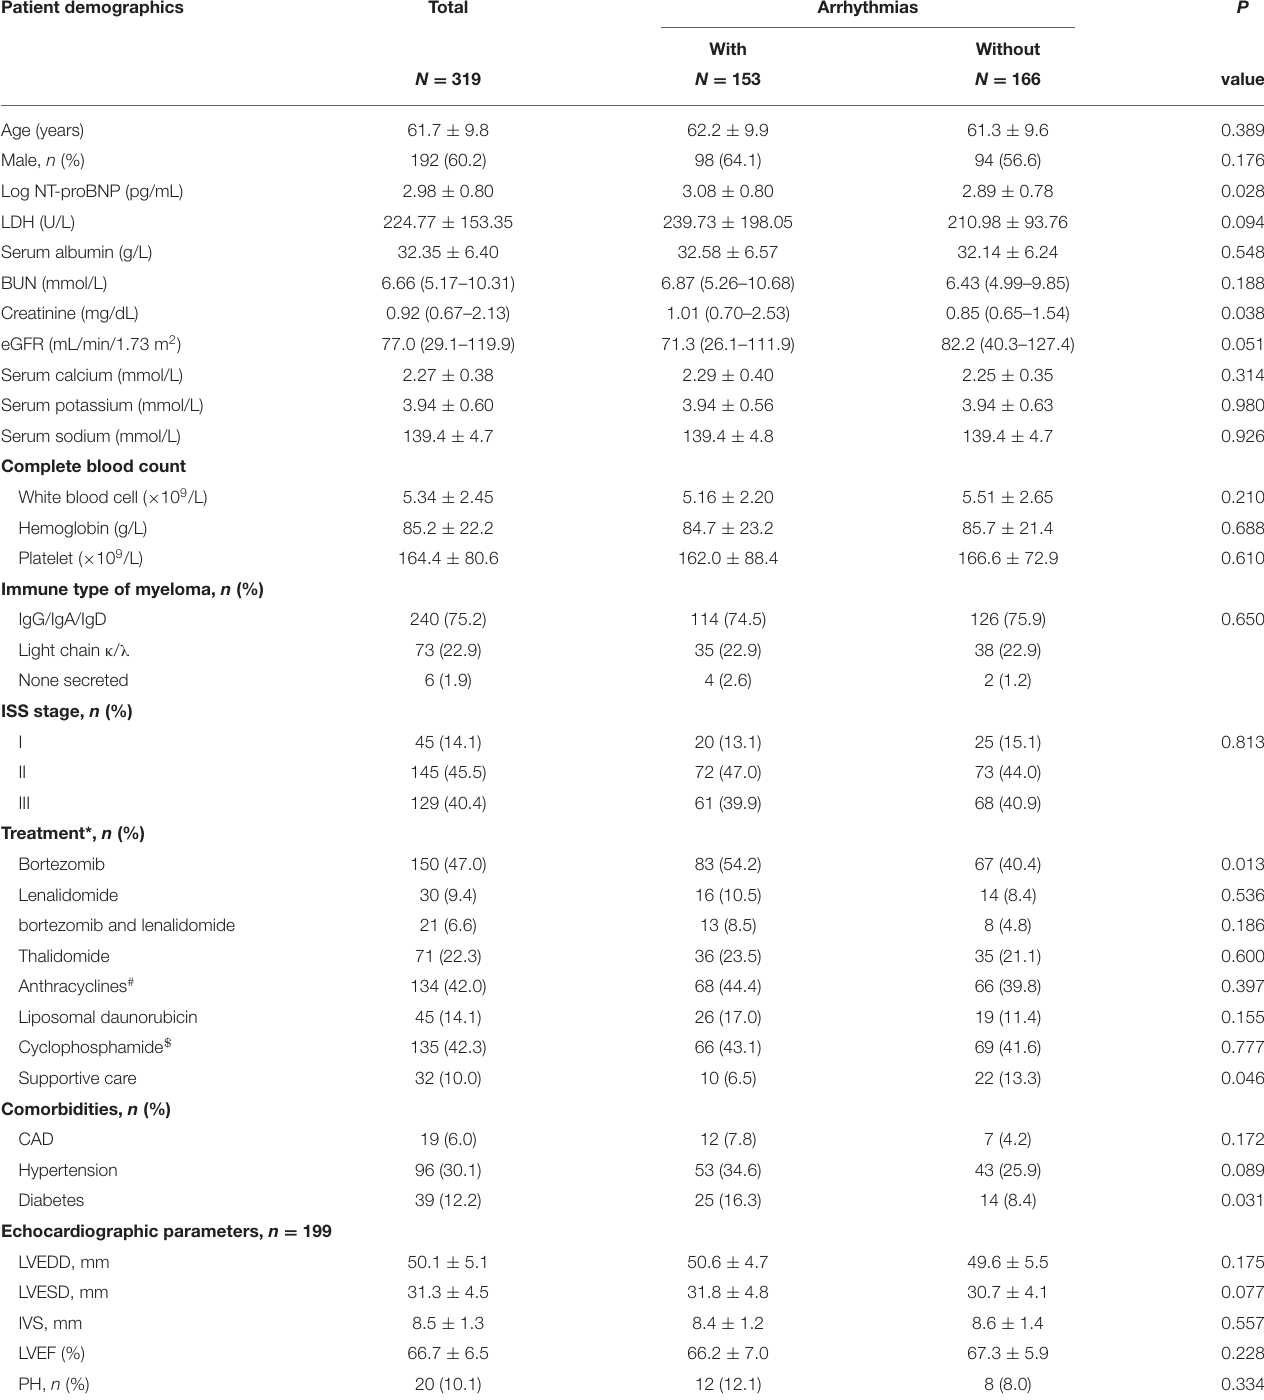
TABLE 1 | Baseline characteristics of all